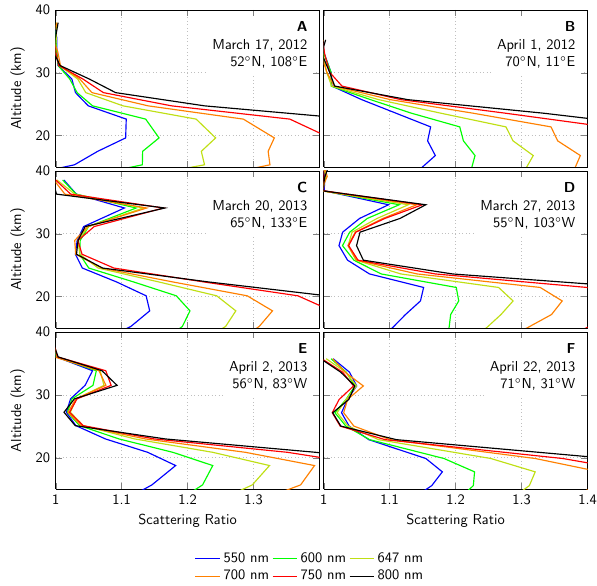
Fig. 1. Scattering ratios from six OSIRIS scans. Panels (A) and (B) are scans from 2012 and show typical background conditions. Pan- els (C) through (F) show scans with enhanced scattering at high altitudes. The enhancements near 30 to 35km are attributed to the meteor, while the lower peak near 20km is the Junge layer. Scat- tering ratios are shown at 6 wavelengths in approximately 50nm intervals from 550 to 800nm.